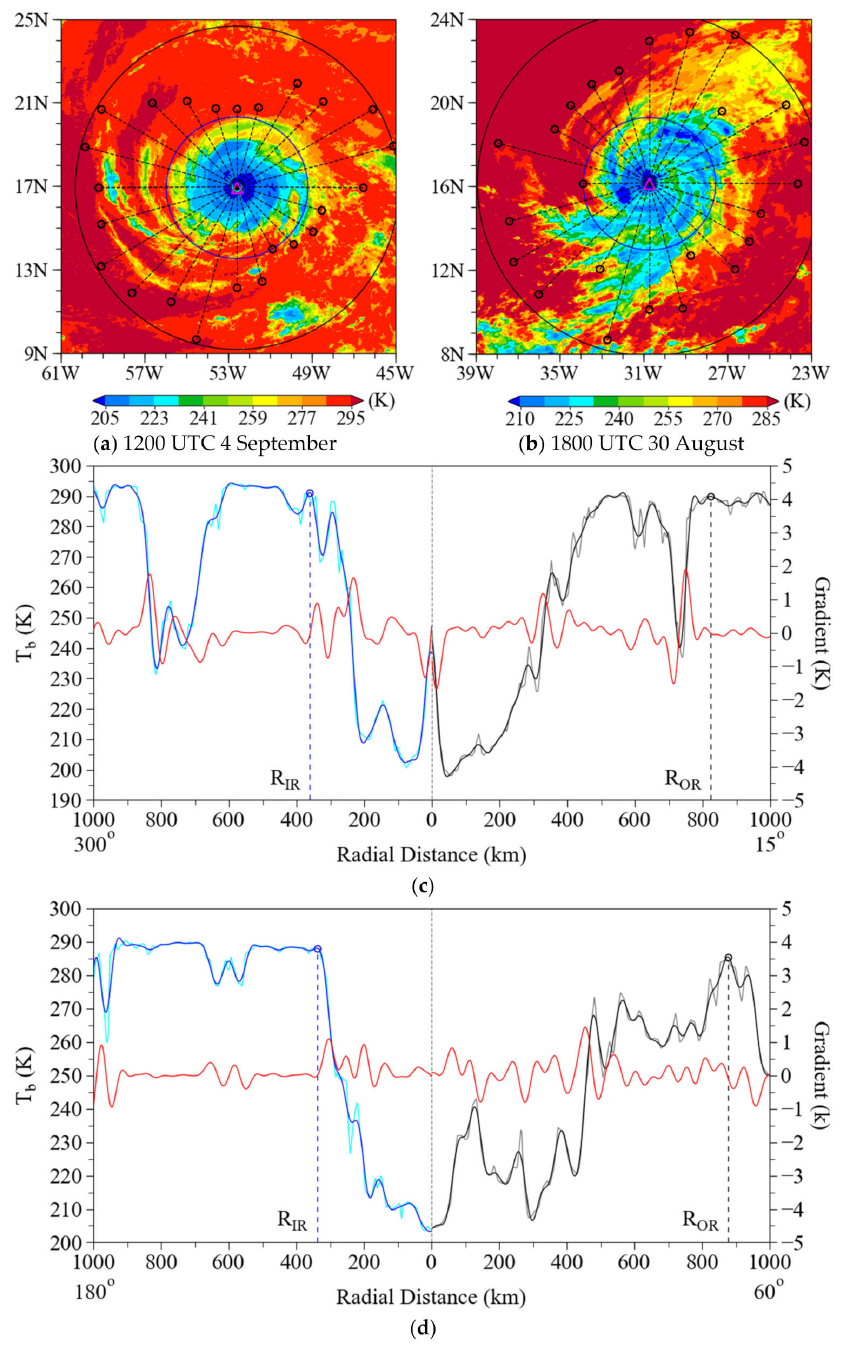
Figure 4. Spatial distributions of TB observations (color shading) around Irma, locations (small black open circles) of the ABI-determined boundaries of the TC cloud area at 24 azimuthal angles of 15 ◦ centered on the ABI-determined center (magenta open triangle), the R IR (blue circle), and R OR (black circle) at about ( a ) 1200 UTC September 4 and ( b ) 1800 UTC August 30, 2017. ( c ) The filtered TB sequences (blue and black curves), the original TB sequences (cyan and gray curves), and the radial gradients of filtered TB sequences (red curves) along the 300 ◦ and 15 ◦ directions counterclockwise from due east at about 1200 UTC September 4, 2017. The R IR (blue dashed vertical line) and R OR (black dashed vertical line) are marked. ( d ) The same as ( c ), with the exception for the time of 1800 UTC August 30,